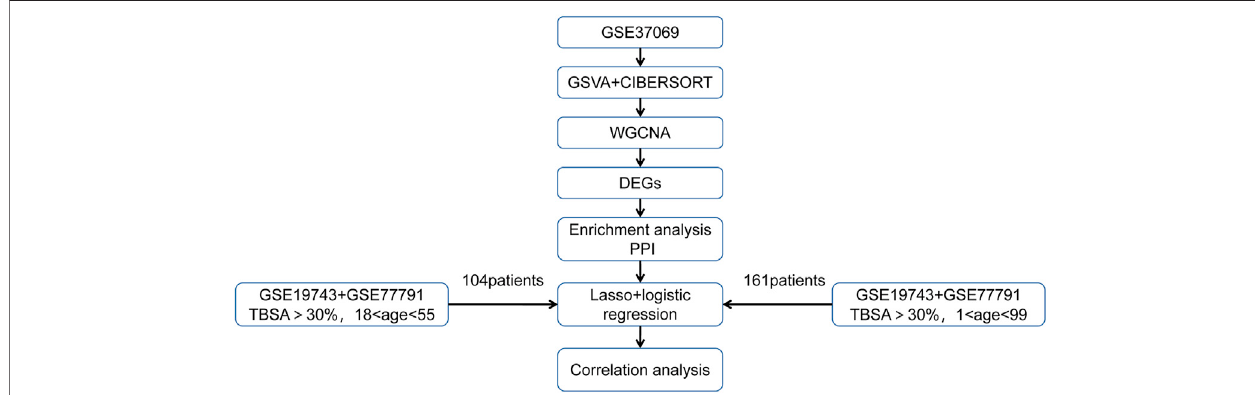
FIGURE 1 | A graphical summary of the research design.